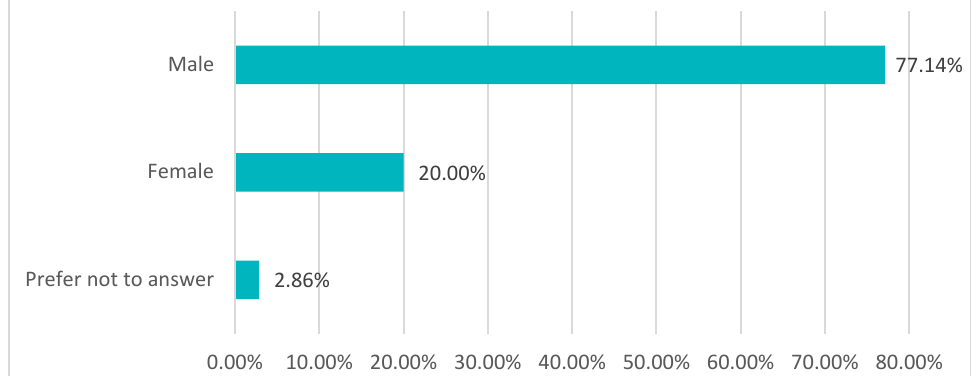
Figure 8. Gender distribution of survey respondents.